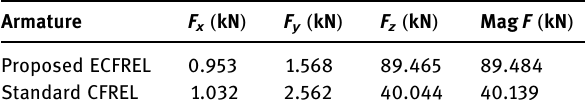
Table 2: Electromagnetic force on